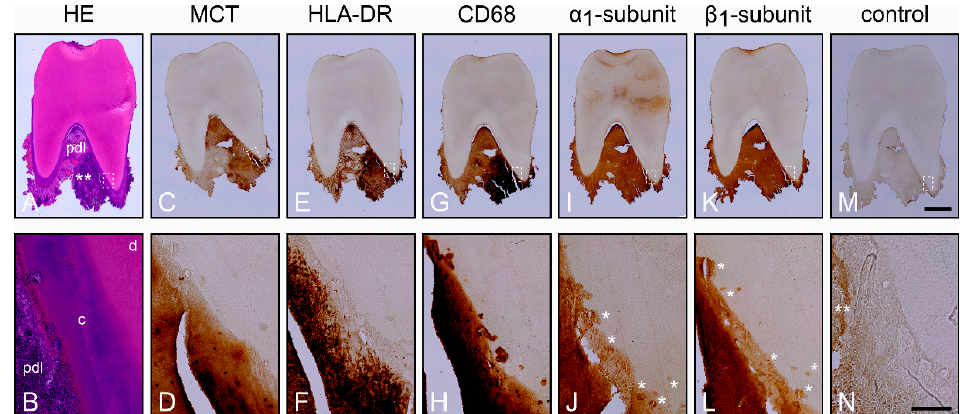
Figure 2. Histological characterization of the inflamed periodontium and localization of the α 1 - and β 1 -subunits of sGC in cementoclasts. Consecutive sections of a representative molar with adherent clinically inflamed periodontium were stained with Hematoxylin and Eosin (HE) ( A , B ) and incubated with antibodies for MCT ( C , D ), HLA-DR ( E , F ), Cluster of Differentiation 68 (CD68) ( G , H ), α 1 -subunit ( I , J ), and β 1 -subunit ( K , L ). Incubation of the sections without primary antibodies served as a control ( M , N ). The images in the upper row show an overview of the consecutive sections, while the detailed images in the lower row show the regions represented by the rectangle in the overview images of the upper row. d = dentin, c = cementum, and pdl = periodontal ligament. Asterisks in ( J ) and ( L ) shown cementoclasts in resorption lacunae, while asterisks in ( N ) only show an artifact. Scale bar = 2 mm ( M ) and = 200 µm ( N ).